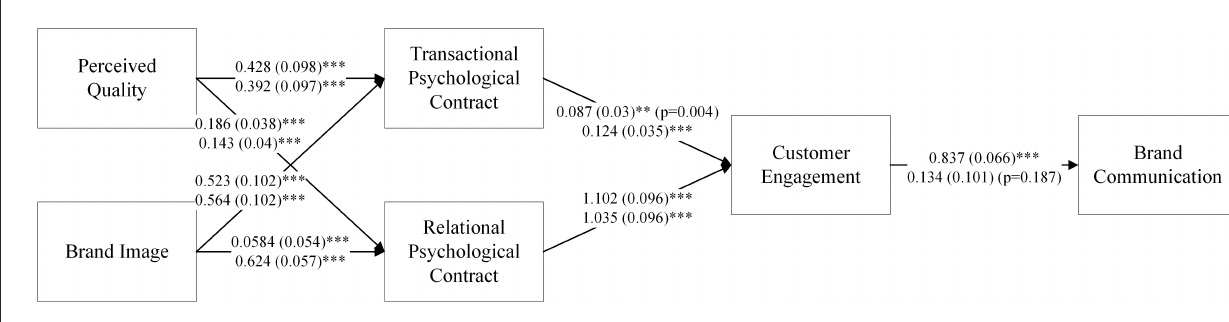
FIGURE2 SEM results of the hybrid communication model in utilitarian and hedonic aspects. N = 575; *** P < 0.001, ** P <